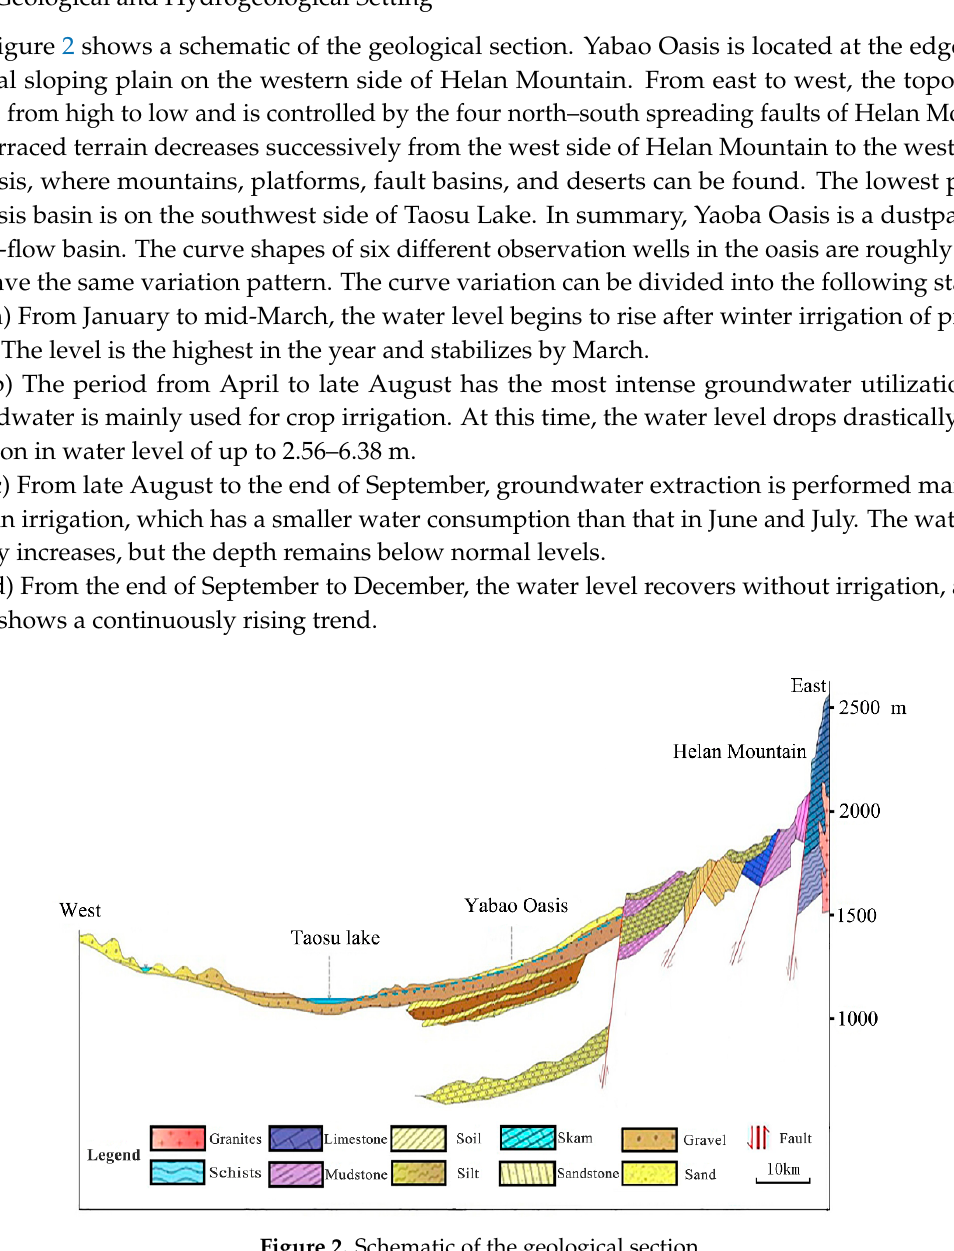
Figure 2. Schematic of the geological section.